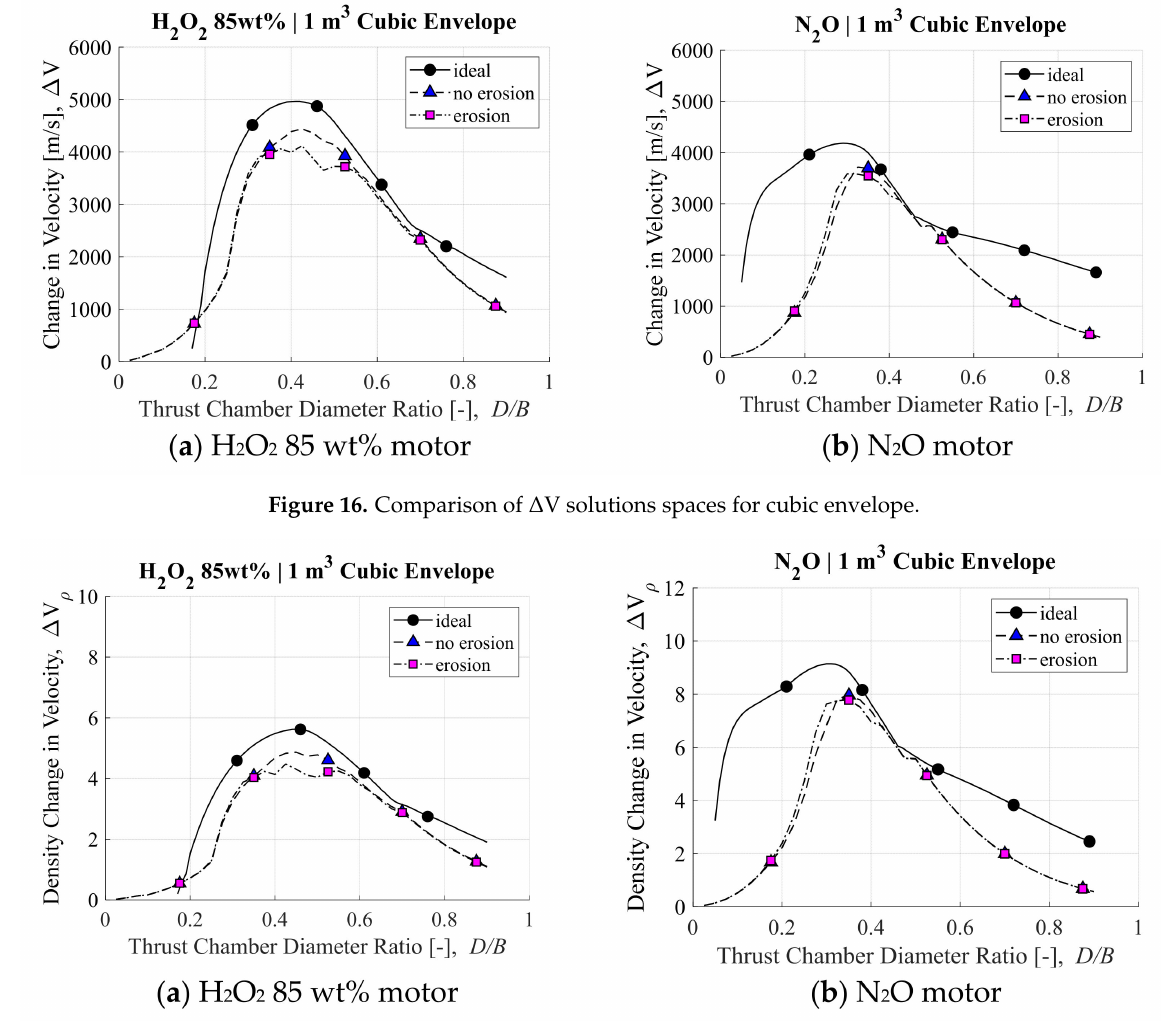
Figure 17. Comparison of ∆ V ρ solutions spaces for cubic